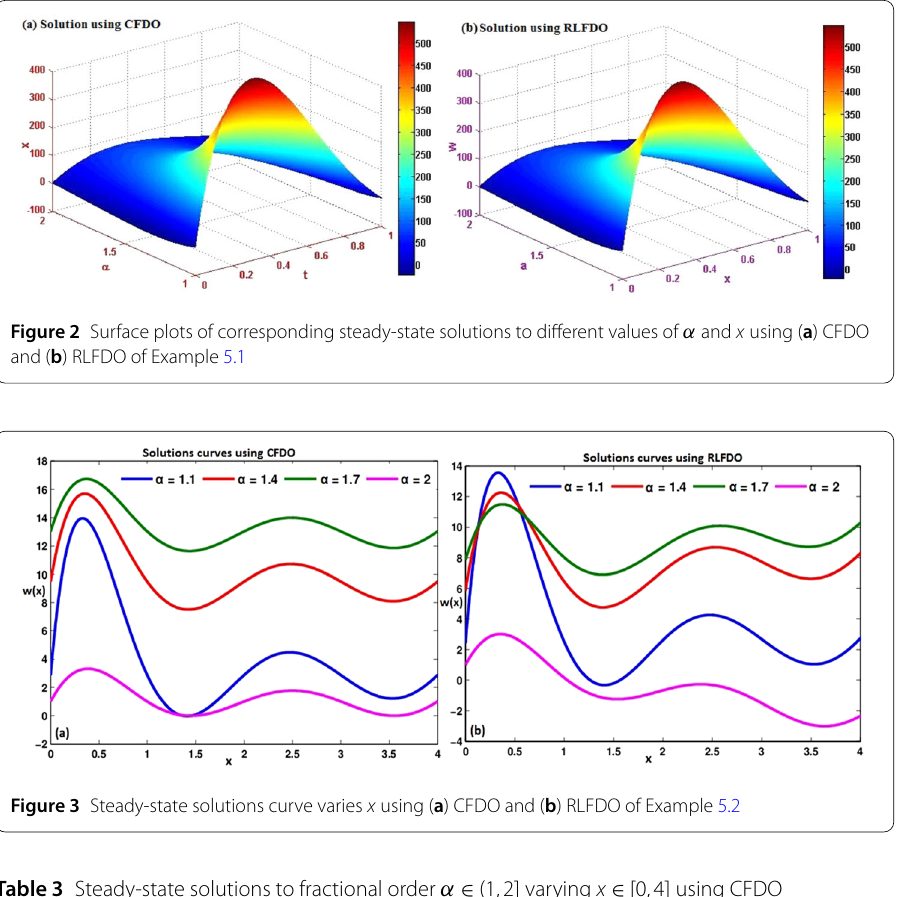
Table 3 Steady-state solutions to fractional order α ∈ (1,2] varying x ∈ [0,4] using CFDO α x 0 0.8 1.6